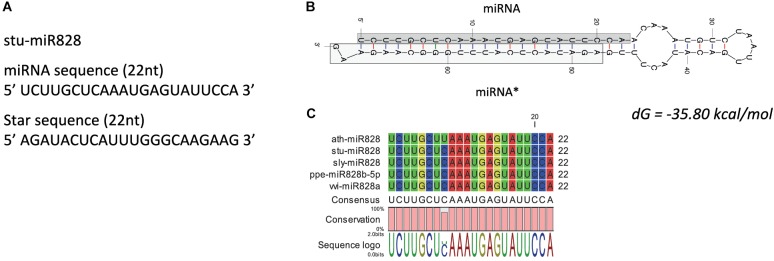
miR828 in potato. (A) stu-miR828 miRNA and star sequence. (B) The predicted secondary structure of stu-miR828 (Mfold) with free energy (dG); miRNA∗ shows the star sequence. (C) Alignment of arabidopsis, potato, tomato, peach and grapevine miR828.